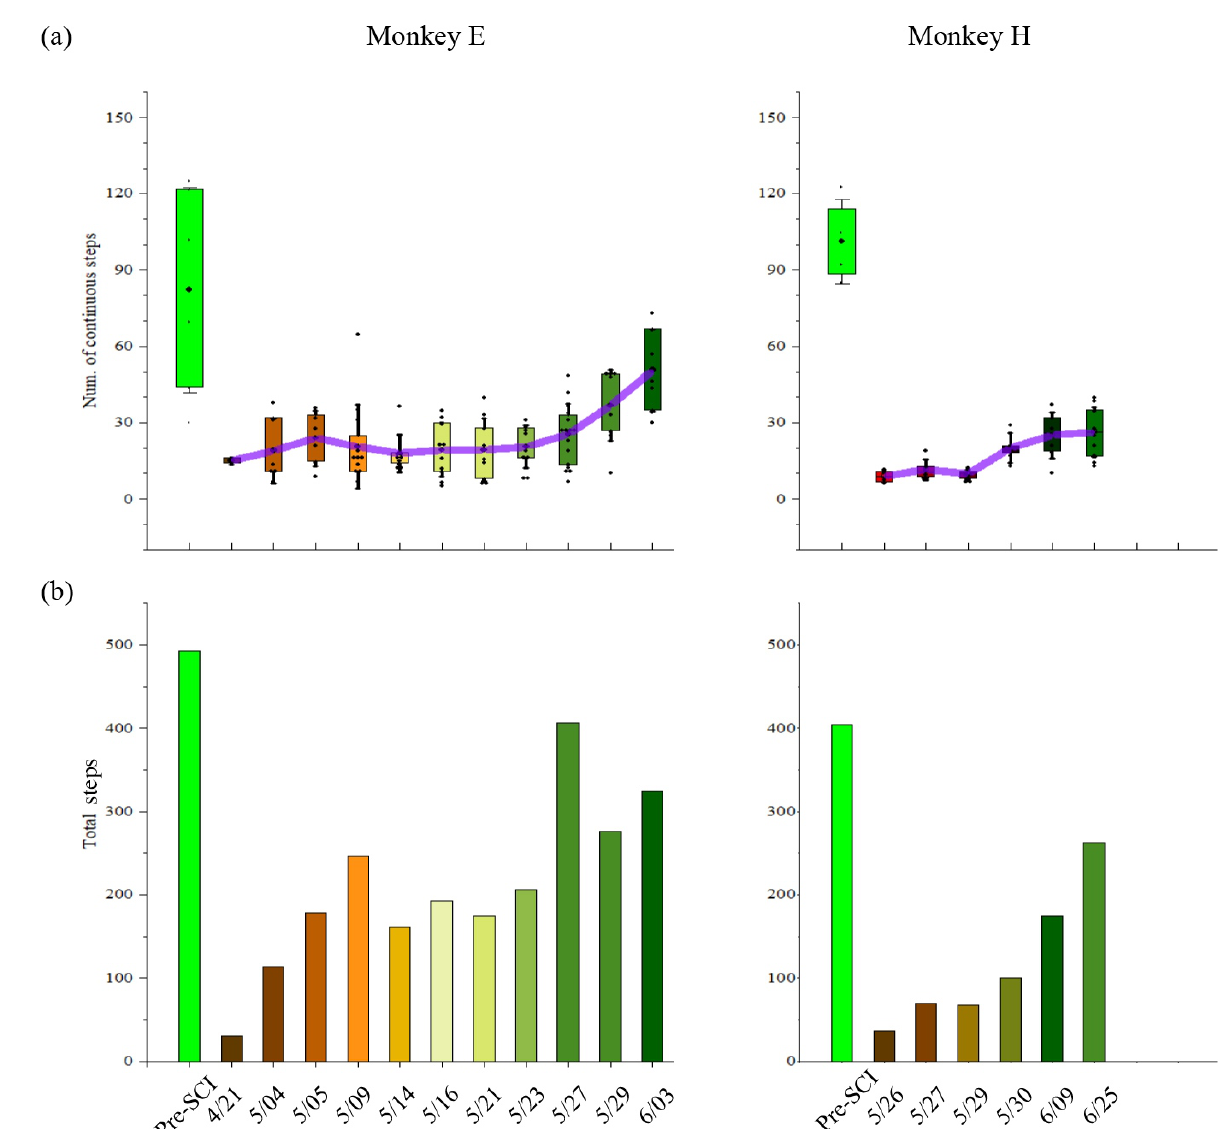
Figure 5. Behavioral performance of the monkeys. ( a ) Mean (+SD) values for the number of consecutive steps in each trial. Dots represent individual values in each trial. Purple lines connect the mean values of each session (day). ( b ) Total steps in each session (day). Blue color represents pre-SCI phase; gradient colors represent post-SCI phase. The x-axes indicate on which day our datasets were obtained for monkeys E and